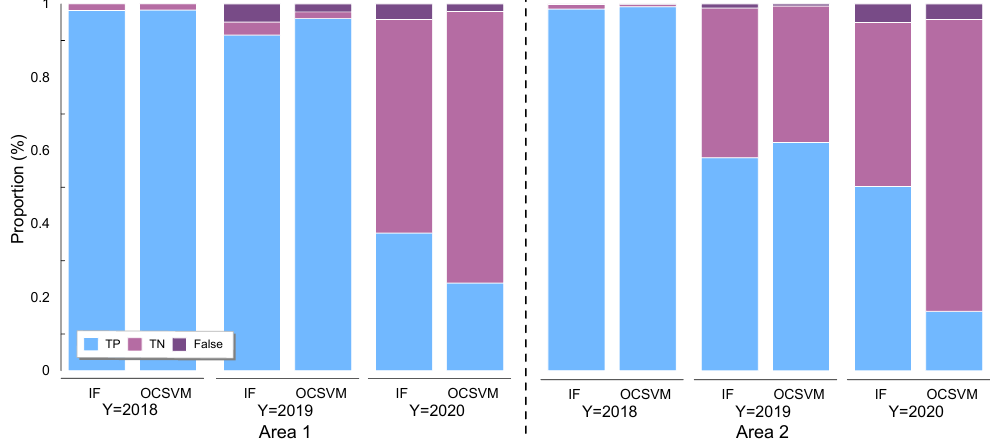
Figure 13. TP, TN and False proportions for each method and epoch.